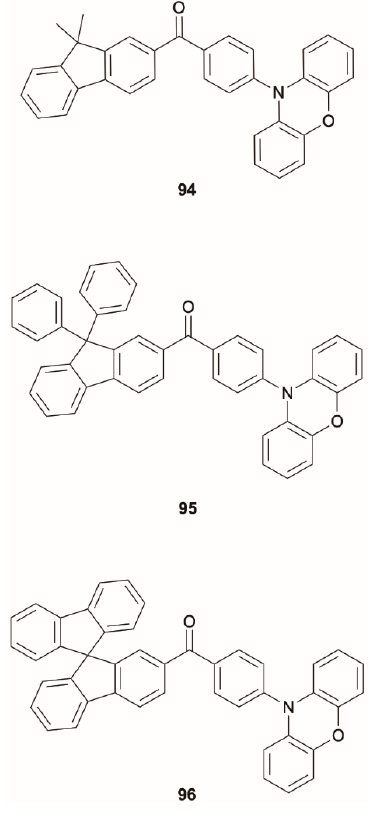
Adapted with permission from [81], Copyright 2019, American Chemical